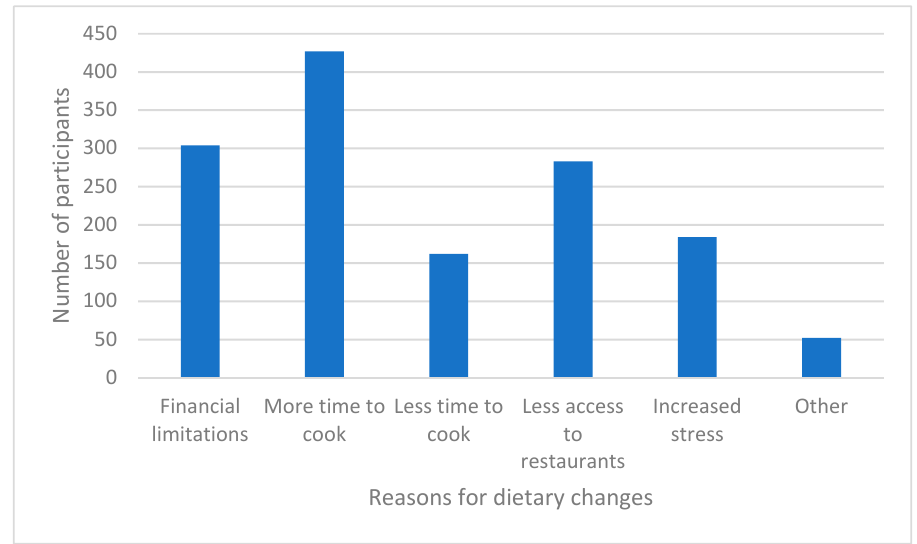
Figure 10 . Reasons for perceived COVID-19-related dietary changes in the household . Figure 10. Reasons for perceived COVID-19-related dietary changes in the household.